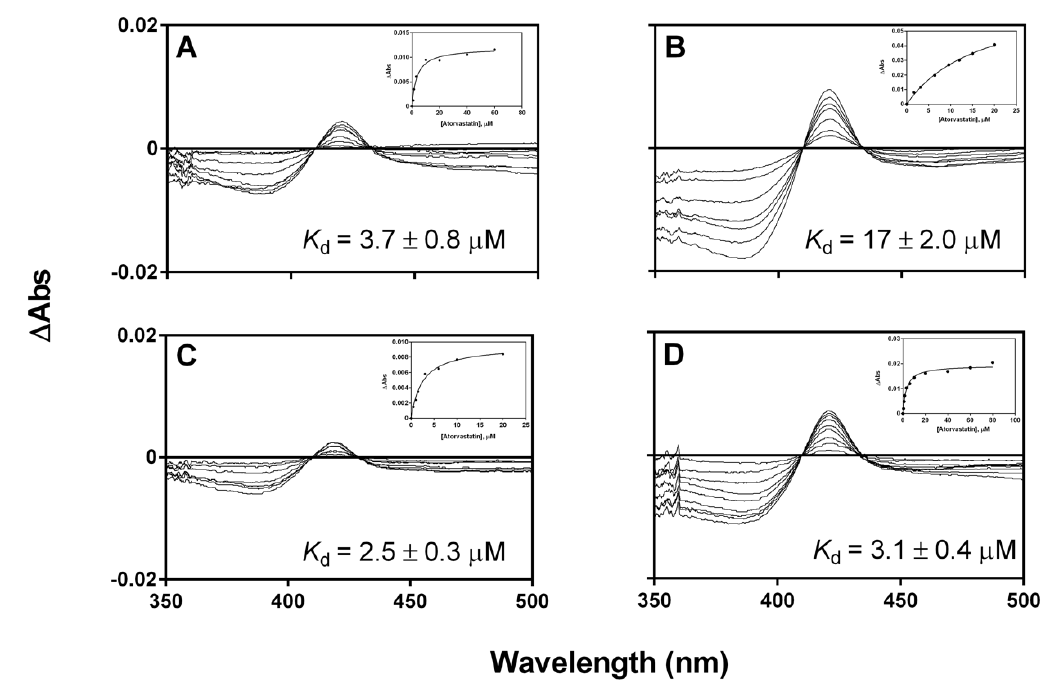
Figure 8. Binding titration of atorvastatin to the CYP102A1. The samples for binding titration contained 0–100 µ M atorvastatin in 100 mM of a potassium phosphate buffer (pH 7.4) and 1 µ M of M179 ( A ), M221 ( B ), M371 ( C ), and M387 ( D ). Spectrally determined dissociation constants ( K d ) were also shown.